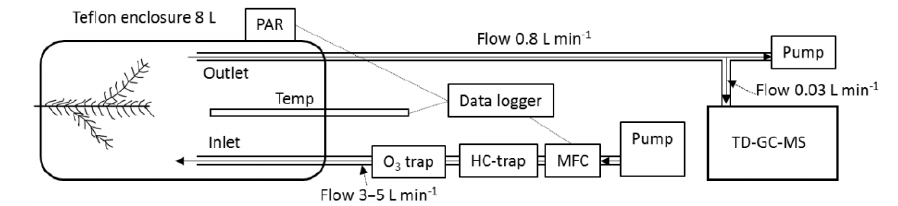
Figure 1. The emission measurement